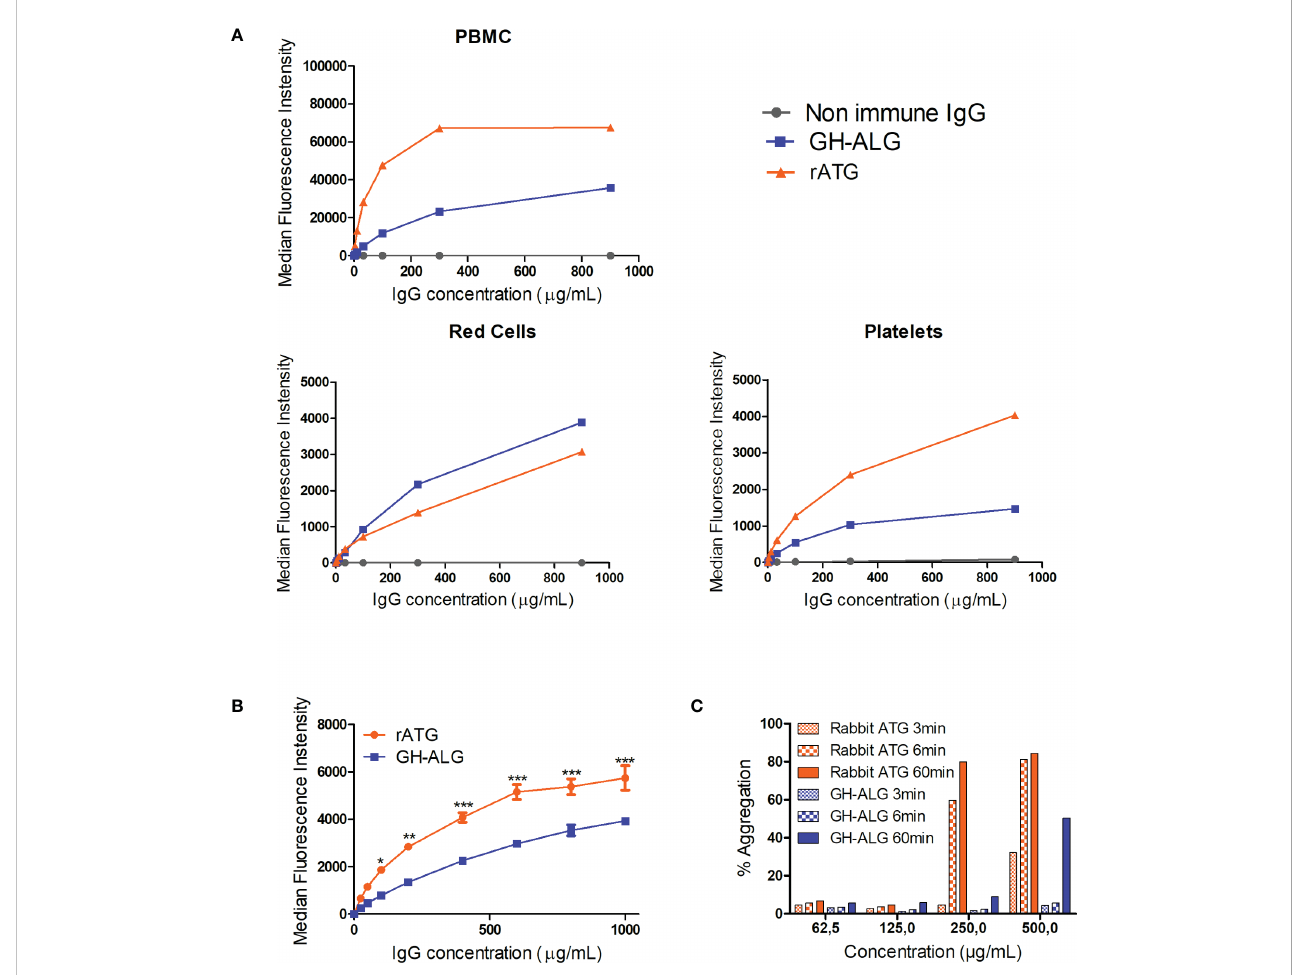
FIGURE 1 Interaction between GH-ALG and human blood cells. (A) Binding of GH-ALG or rabbit ATG to human PBMCs, red cells and platelets was investigated by fl ow cytometry. Cells were incubated with increasing concentrations of GH-ALG or rabbit ATG. Nonimmune IgG was used as a control. After washing, bound IgG was detected by fl ow cytometry using a FITC-conjugated anti-pig antibody or FITC-conjugated anti-rabbit antibody (N=3). (B) Direct comparison of GH-ALG and rabbit ATG binding to human platelets. Human platelets were incubated with increasing doses of GH-ALG or rabbit ATG. Attached antibodies were then detected using AF488-conjugated protein G and fl ow cytometry analysis. The data are expressed as means ± SEM (N=3). Two-way ANOVA (*, p<0.5; **, p<0.01; ***, p<0.005). (C) Platelet aggregation assays. Human platelets were puri fi ed from citrated blood, and aggregation was measured by turbidimetry using a TA-8 V platelet aggregometer (Stago). One representative experiment from two is shown. .